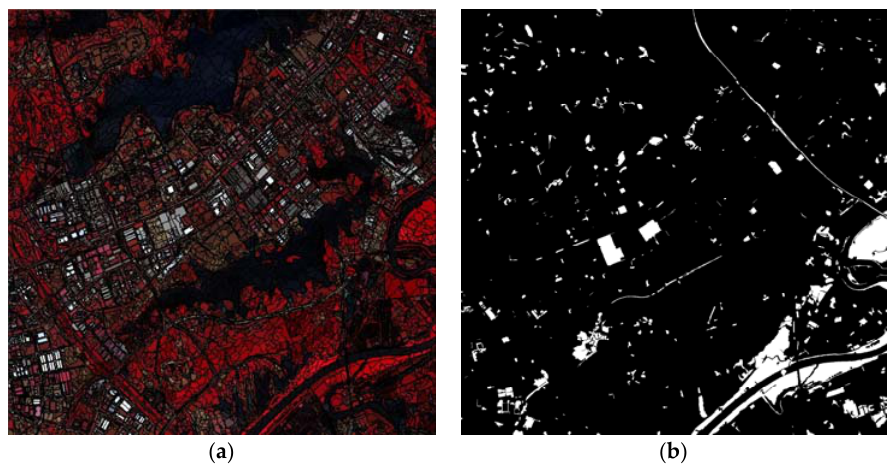
Figure 5. ( a ) The segmentation object map; and ( b ) binary change map after D–S fusion.